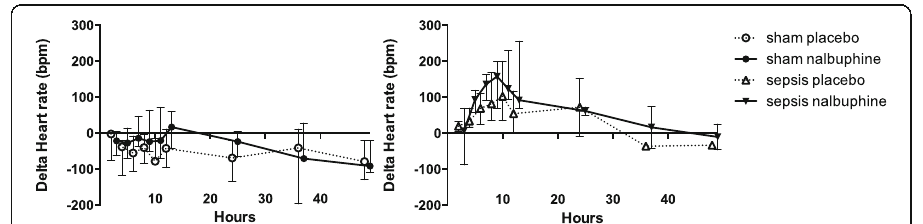
Fig. 6 Heart rate changes over time. Delta heart rate was calculated as heart rate at time point x minus heart rate at baseline. Data are shown as mean±standard deviation. Repeated measures ANOVA revealed a time effect for sham and septic animals ( p <0.01, each). There was no group effect or time-group interaction due